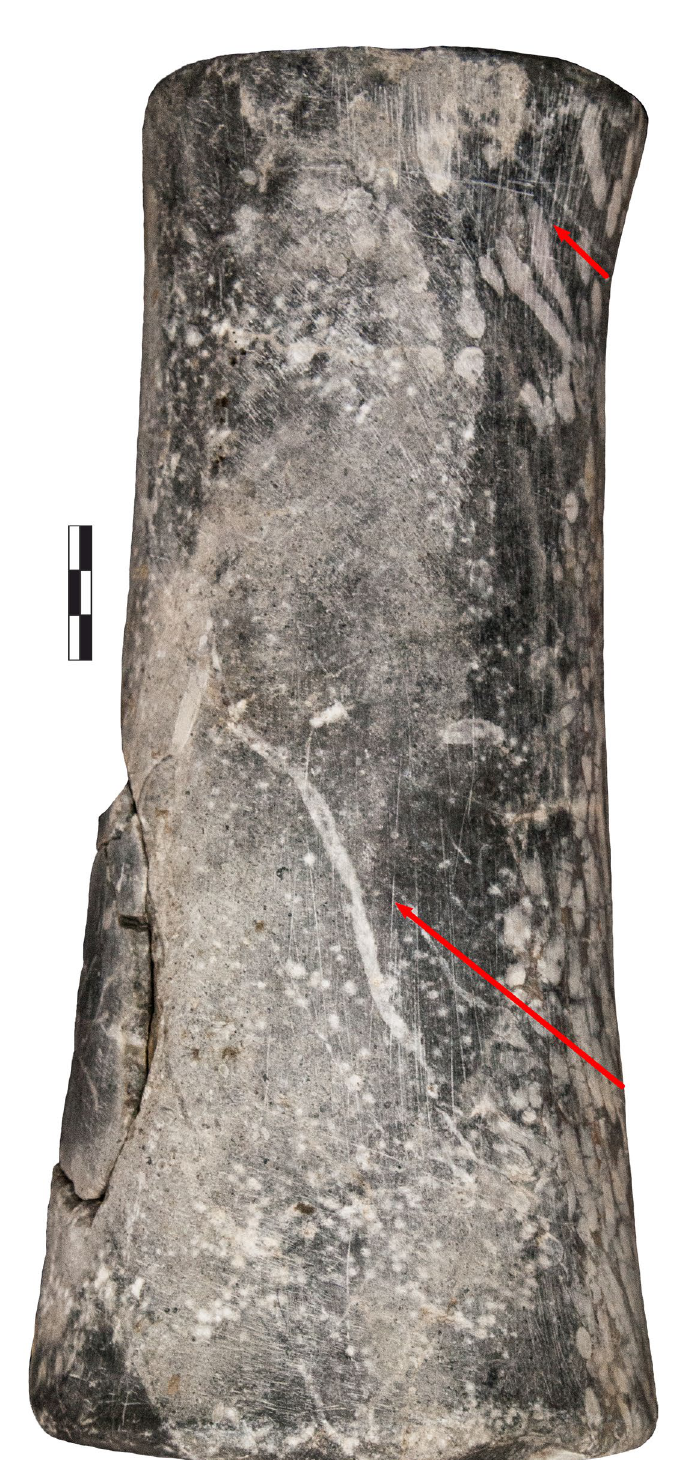
Figure 17. Abrasive traces along the side of a miniature column from Gonur Depe (from the depositories of the Local history museum of Mary province, Turkmenistan). Scale bar is 3 cm long, separated into three 1 cm